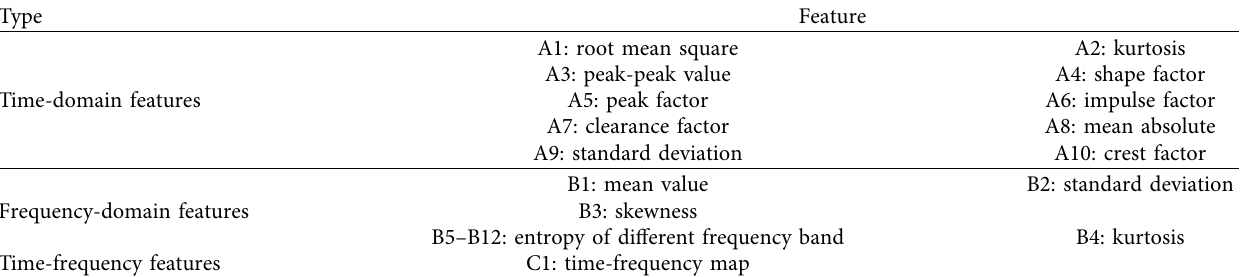
Figure 4: The acceleration signal on the horizontal direction. Table 3: Features extracted from the vibration signal.